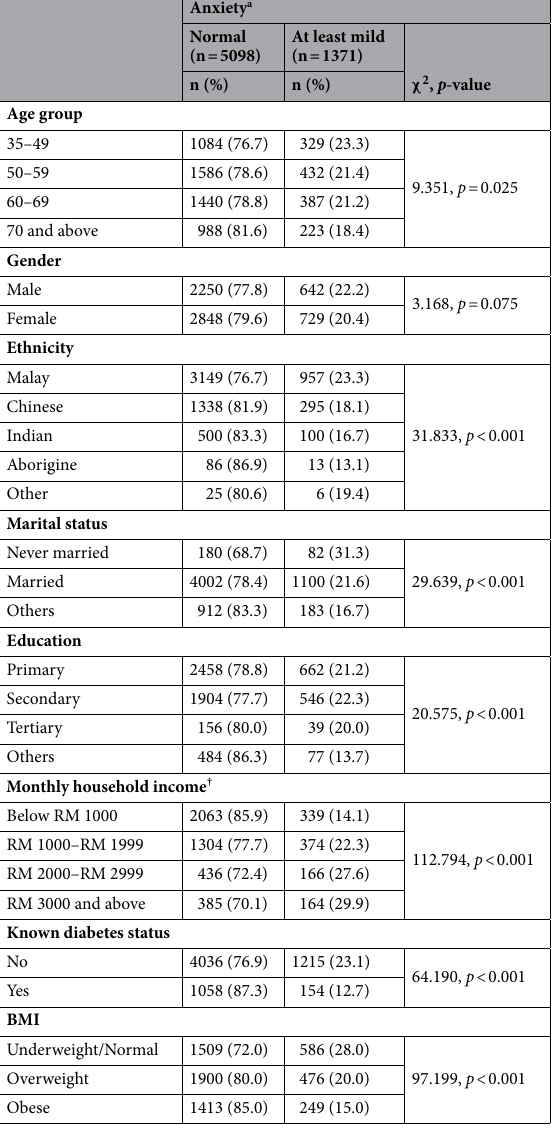
respondents answered the assessment of anxiety was